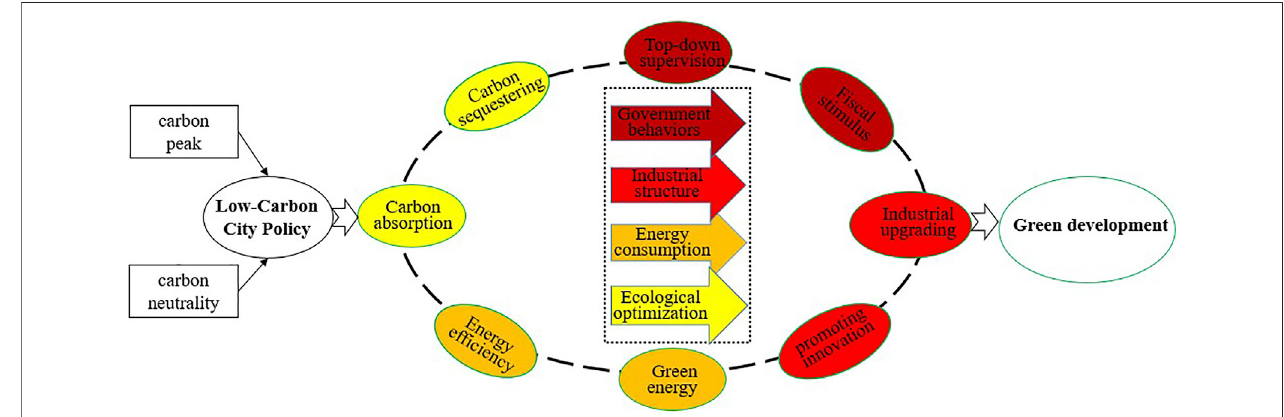
FIGURE 2 | The mechanisms of LCCP affecting carbon